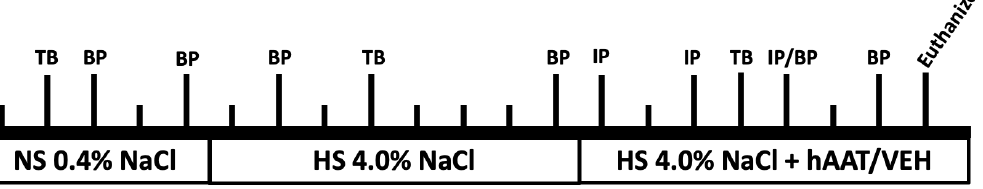
Figure 1. Schematic of study design. Each vertical line represents one day. Tail bleeds (TB), Blood pressure (BP), intraperitoneal (IP) injection of either hAAT or vehicle. There were 3 phases: